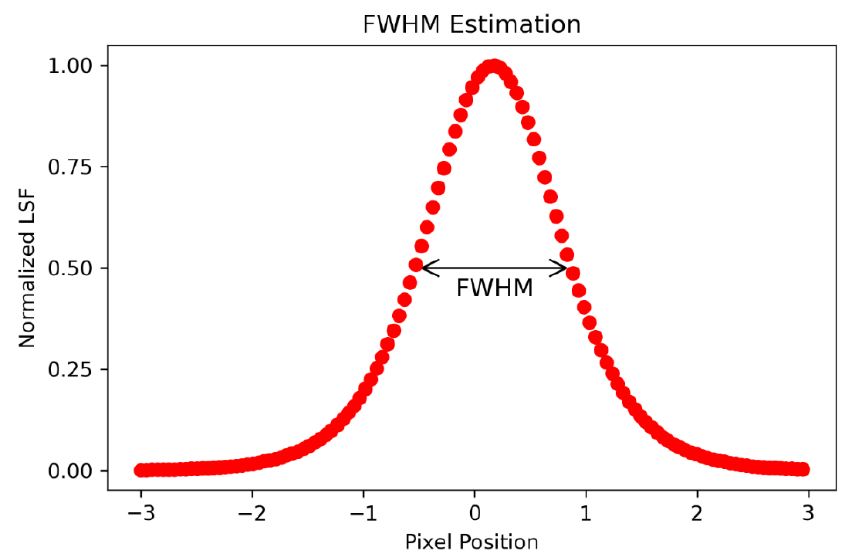
Figure 5. Computation of the FWHM of the normalized LSF.